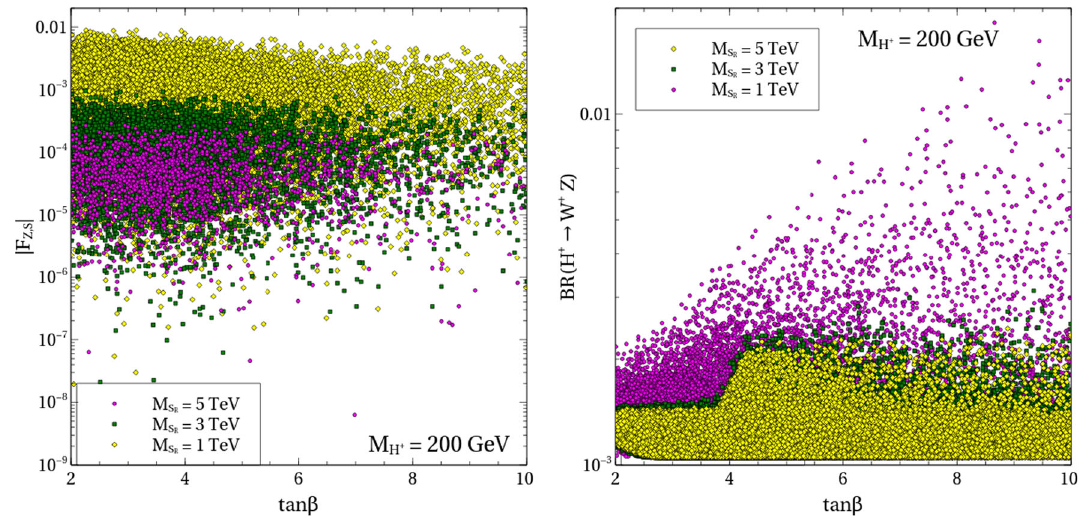
= 1 TeV, 3 TeV and 5 TeV R